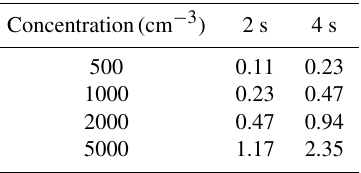
Table 3. Average number of collisions N for 200nm silver iodide particles with a 80µm diameter droplet in concentrations from 500 to 5000cm − 3 air and residence times of 2 and